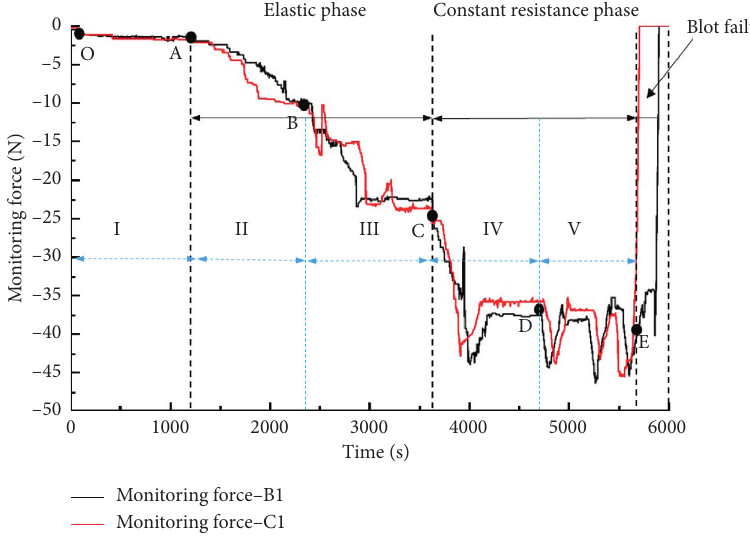
Figure 14: Stress record of the whole test